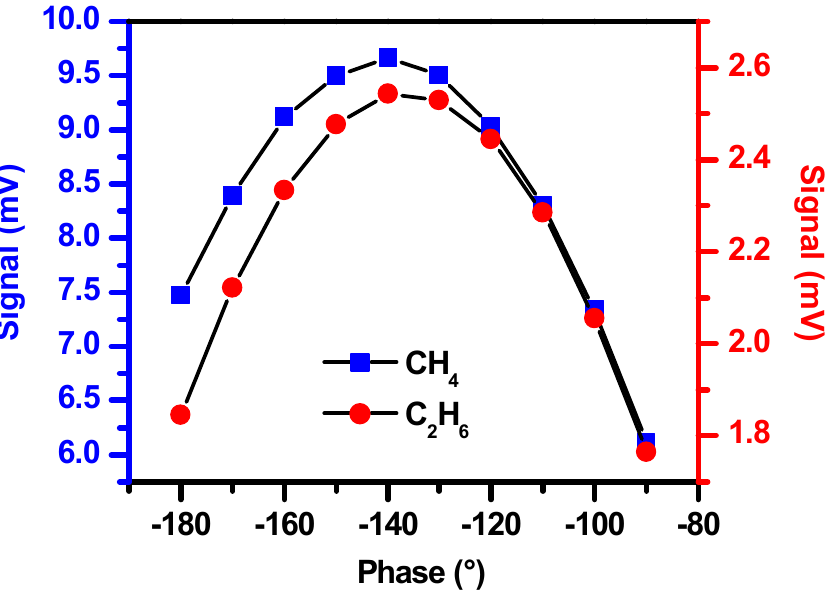
Figure 6. The 2f signal amplitudes of CH 4 and C 2 H 6 vs. modulation phase.